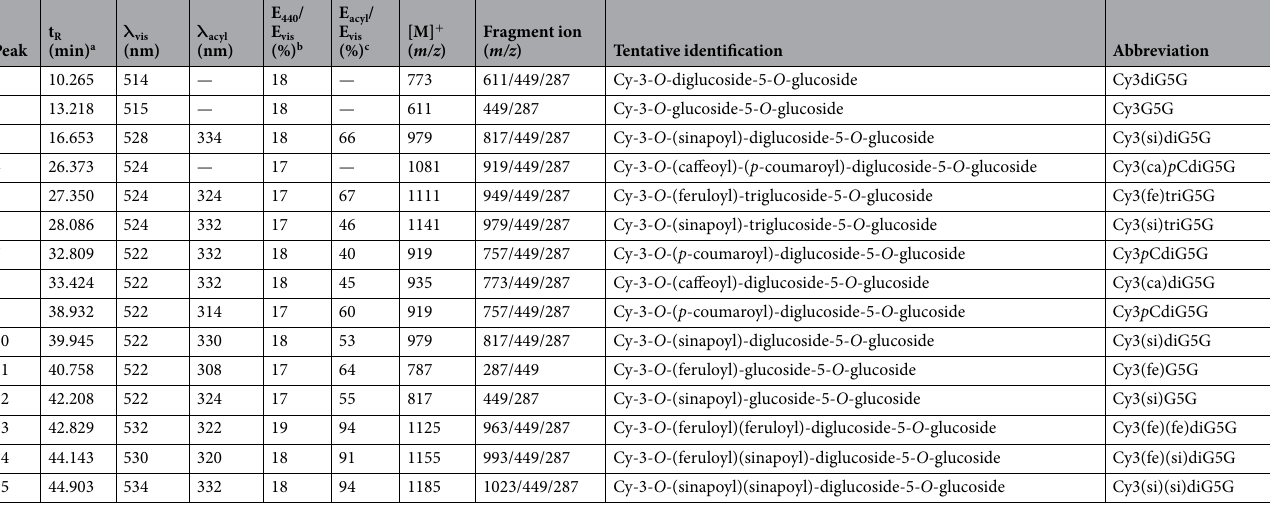
Table 1. The UV-Vis and MS data of the anthocyanin compounds identified from red cabbage in this study. a t b E R , retention time. 440 /E vis , the ratio of the absorbance value at 440 nm and that of the maximum visible